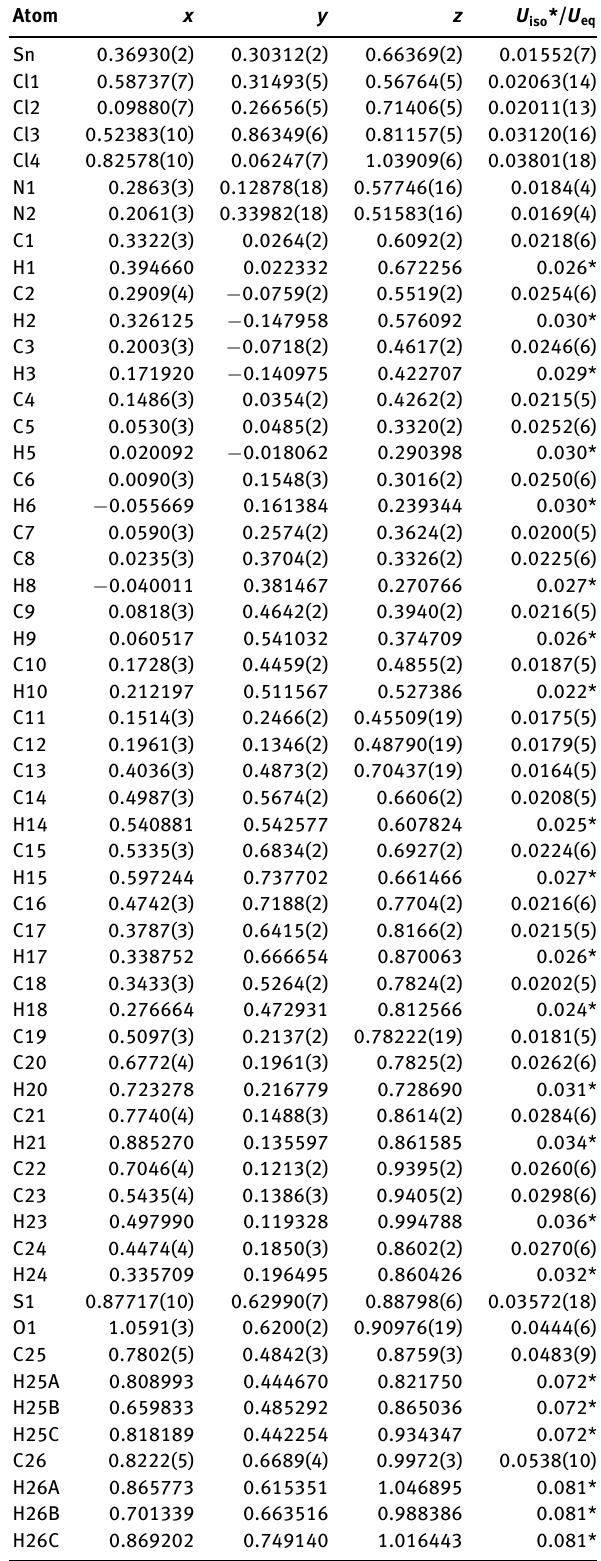
Table 2: Fractional atomic coordinates and isotropic or equivalent isotropic displacement parameters (Å 2